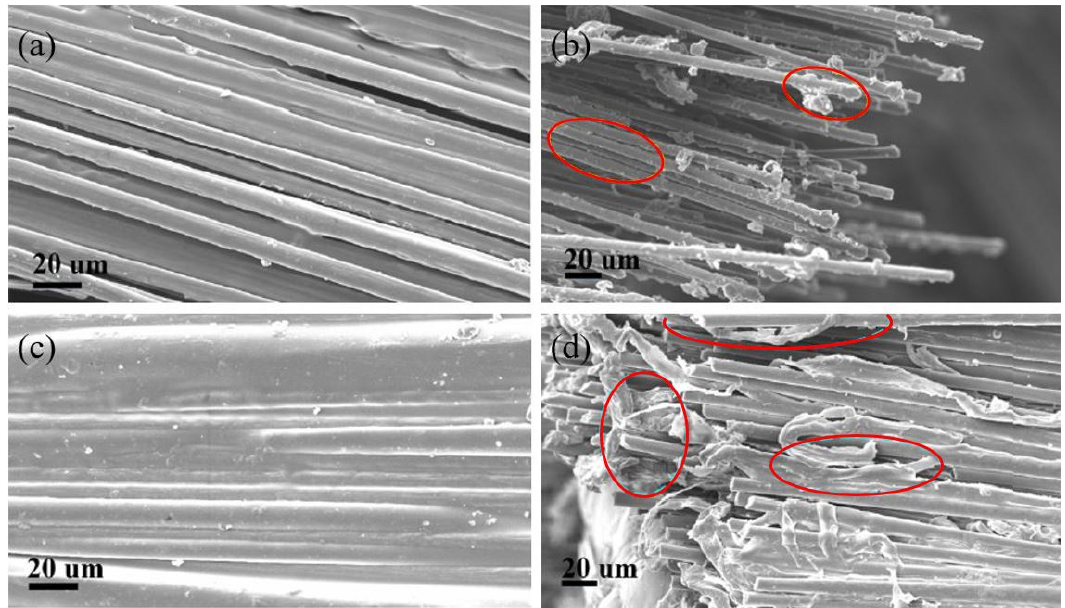
Figure 18. SEM images of CF reinforced PLA filament: ( a ) Untreated filament surface. ( b ) Fibre pull-out of the untreated specimen after the tensile test. ( c ) Chemical treated filament surface. ( d ) Fibre pull-out of the chemical treated specimen after tensile test with better deposition of the matrix on the fibre [126].